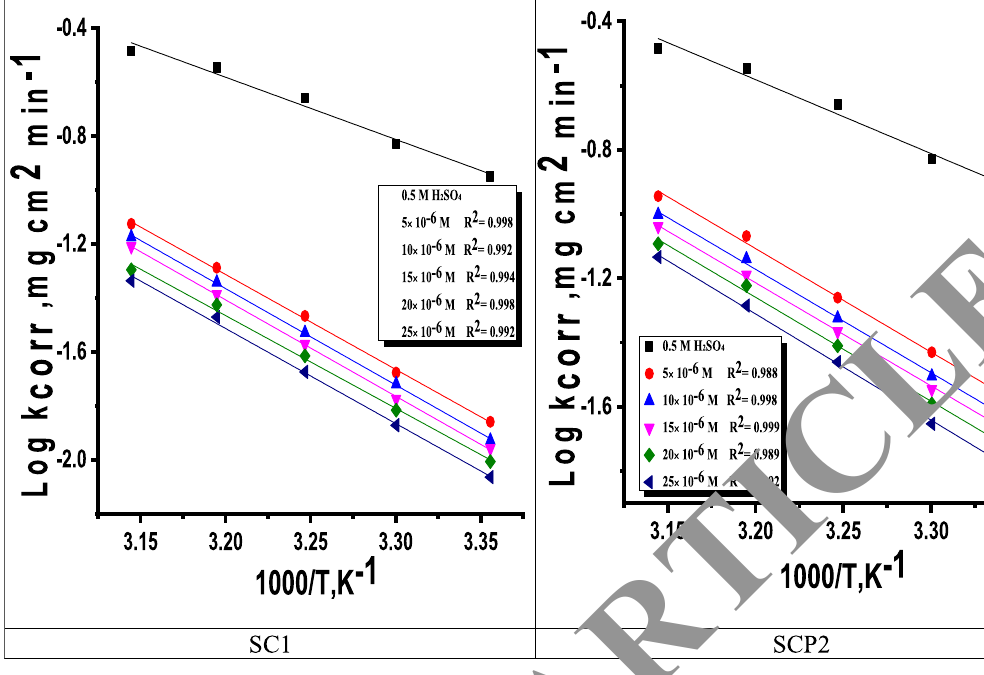
Figure 4. Log k corr versus 1/ T of investigated metal–organic SC1 & SCP2 with and without altered doses of investigated compounds at temperature range 298–318 K.